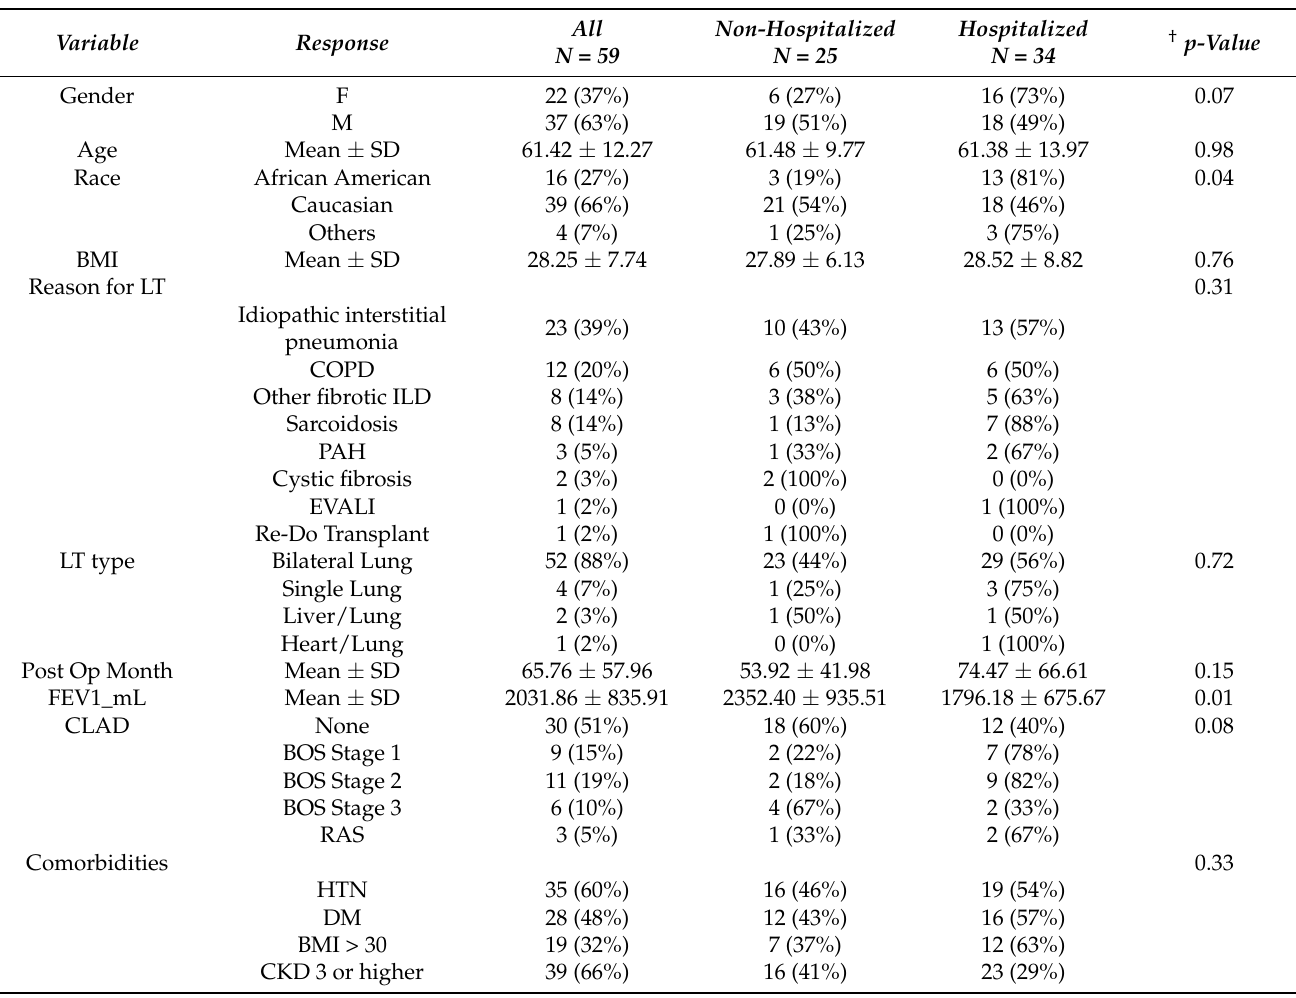
Table 1. Baseline characteristics of hospitalized and non-hospitalized lung transplant recipients with